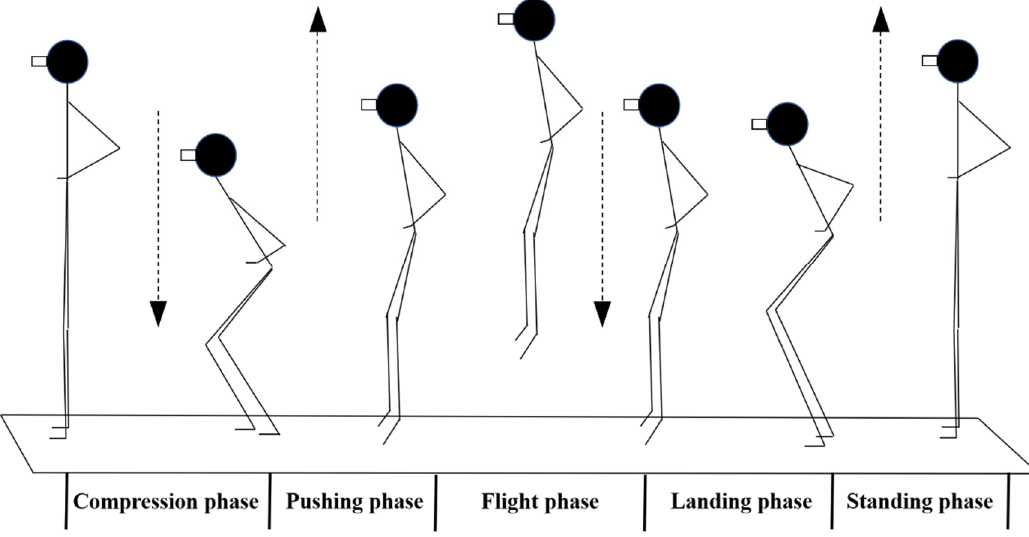
Figure 2. The phase of vertical jumping. Table 2. Kinematic and dynamic parameters in vertical jumping.